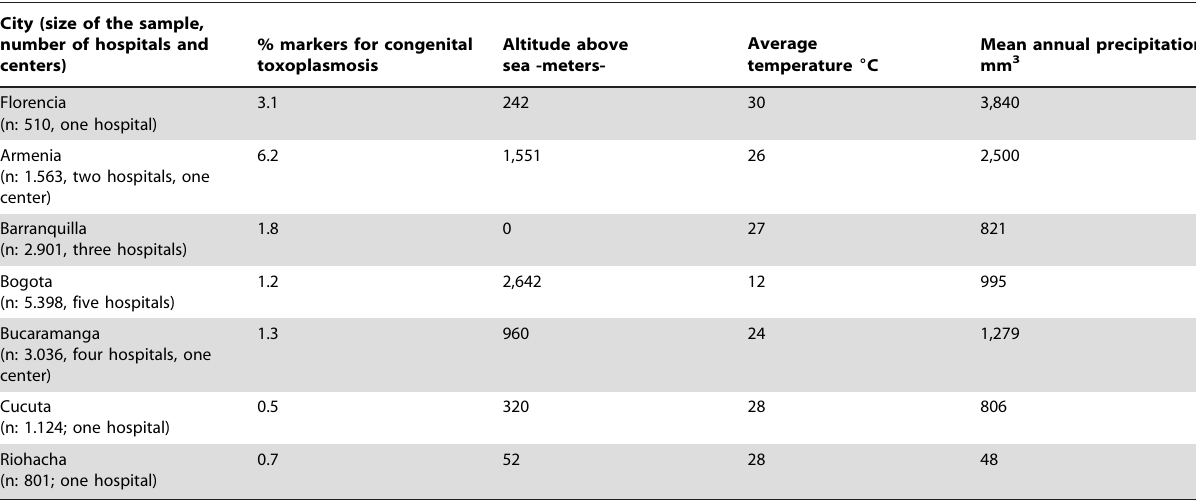
Table 4. Rate of markers for congenital toxoplasmosis and geographical